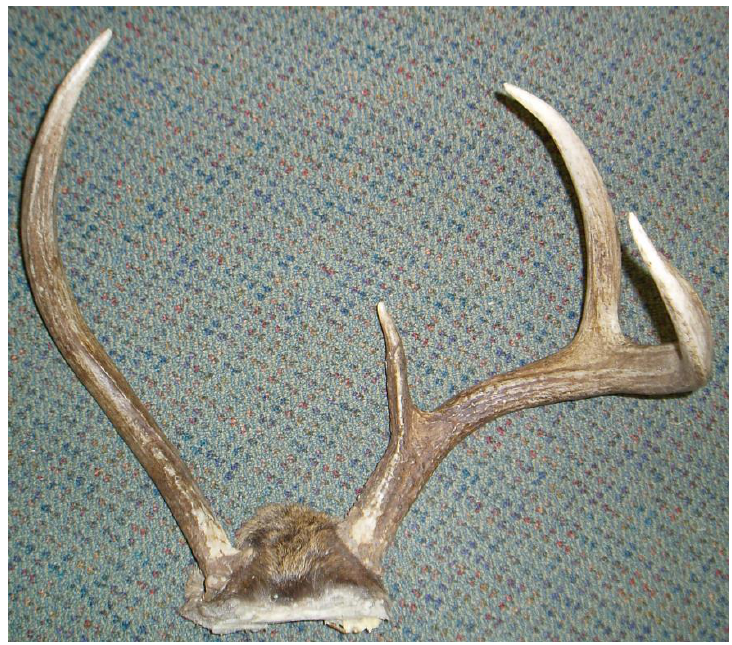
Figure A2. Antlers of a male white-tailed deer ( Odocoileus virginianus ) displaying malformed ant- lers in the absence of pedicle damage. Photograph by Stephen L. Webb.